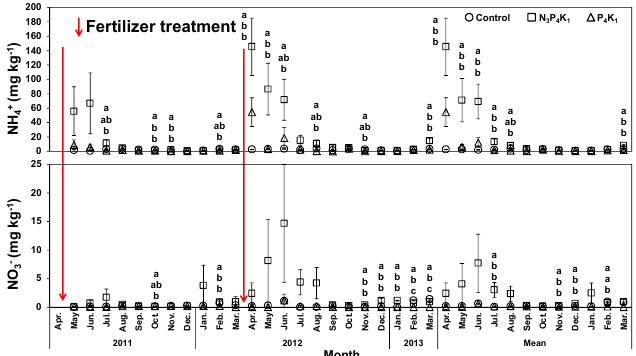
Figure 3. Monthly variation of extractable soil NH 4 + and NO 3 − concentrations for fertilizer and control treatments in red pine stands. Vertical bars represent standard errors ( n = 6). Different letters at each month indicate a significant difference among treatments at p < 0.05.